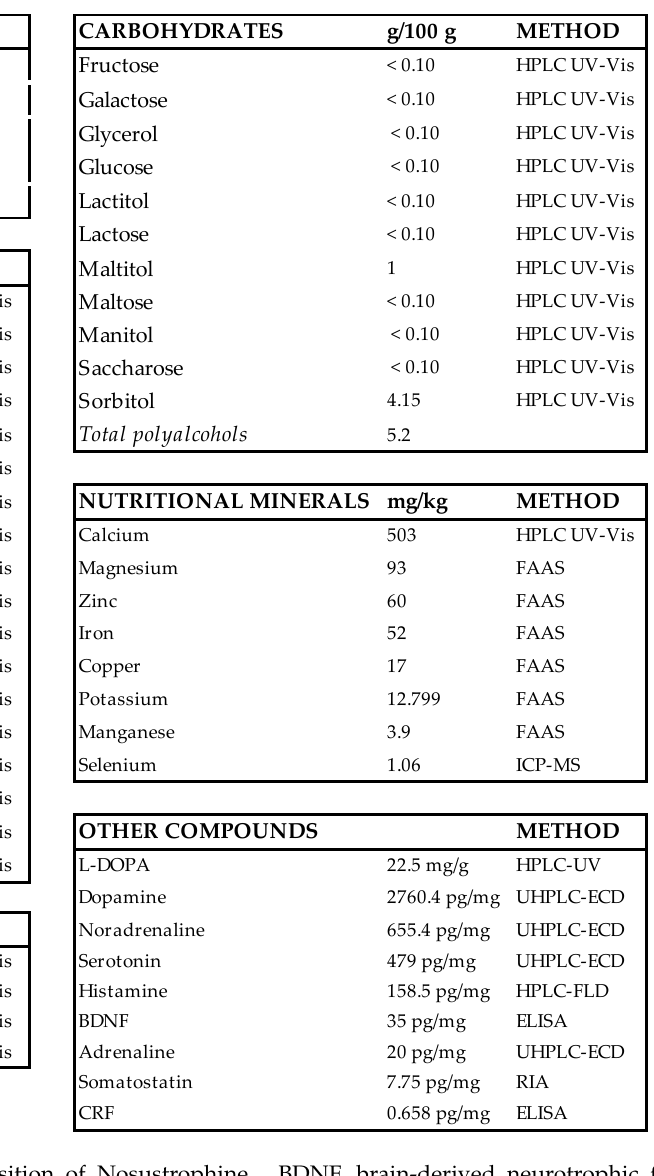
tropin-releasing factor; ELISA, enzyme-linked immunosorbent assay; FAAS, flame atomic